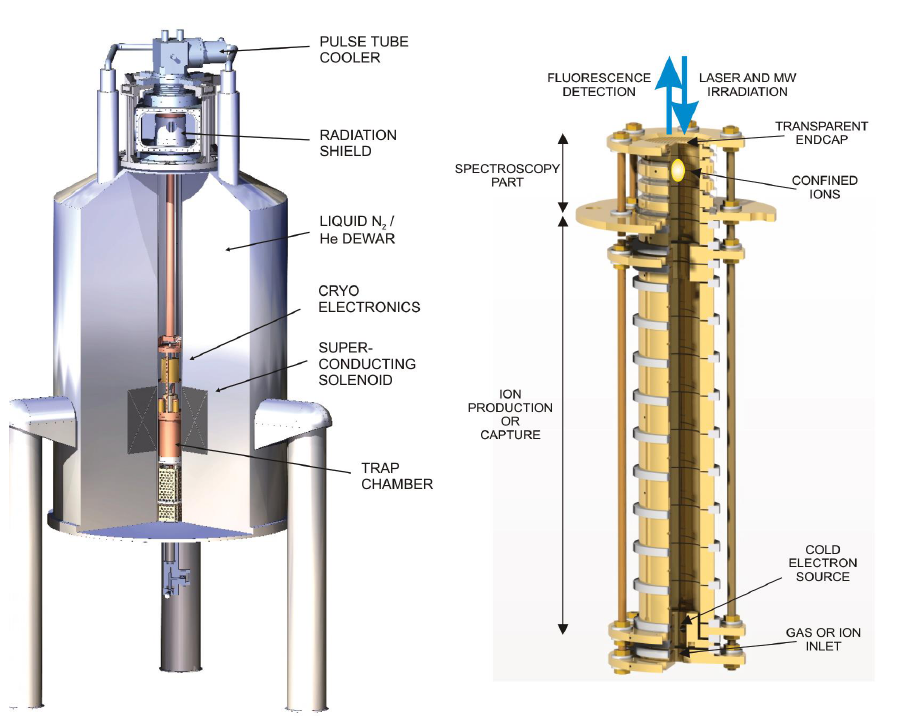
Figure 7. Schematic of the setup inside the superconducting magnet ( left ) and schematic of the Penning-trap arrangement ( right